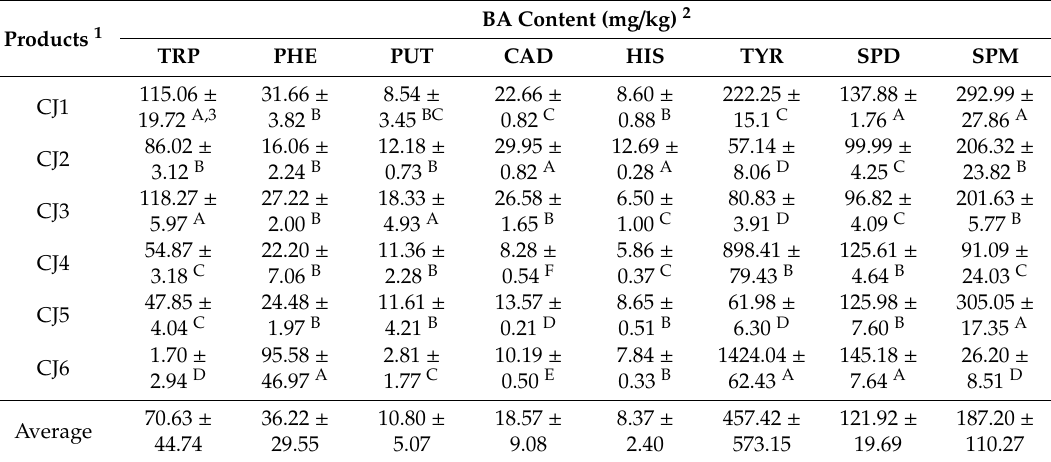
Table 3. Biogenic amine (BA) content of retail Cheonggukjang